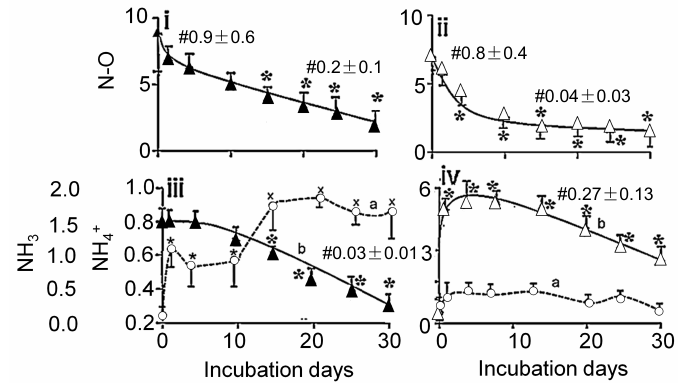
Figure 2. Effects or aerobic (solid line) and anaerobic (broken line) incubation on manure pH ( n = 27). Values are mean ± SD. * p < 0.05, significant when compare with control.